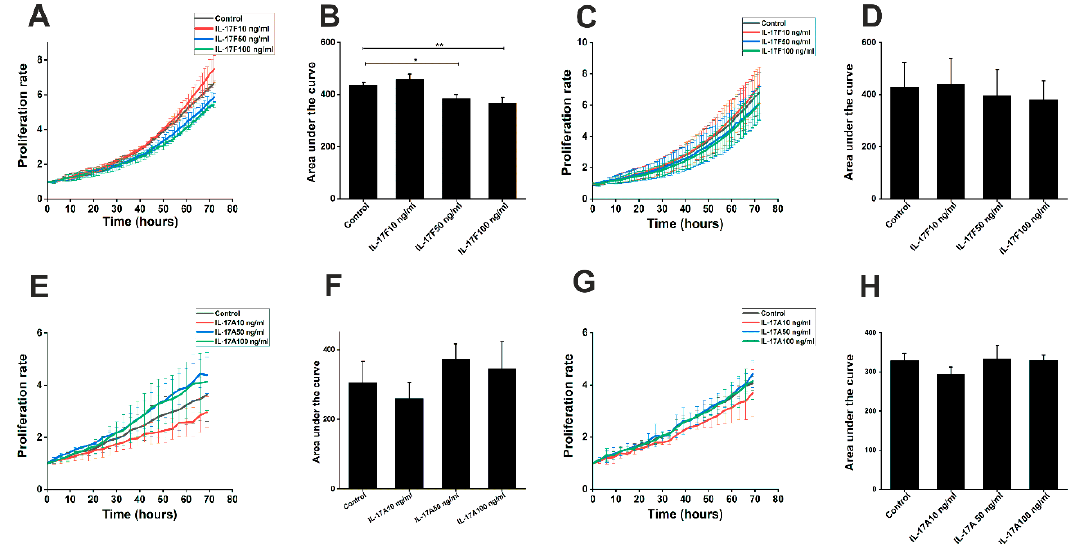
Figure 2. Effects of IL-17F and IL-17A on cancer cell proliferation in the label-free proliferation assay. ( A , B ) IL-17F suppresses HSC-3 cell proliferation at concentrations of 50 ( p = 0.04) and 100 ng/mL ( p = 0.008) compared with non-stimulated control samples. ( C , D ) Treatment of SCC-25 cells with IL-17F shows a similar but non-significant difference. ( E , F ) IL-17A produced an opposite effect to IL-17F and showed a slight induction of HSC-3 cell lines. ( G , H ) Similarly, IL-17A slightly induced SCC-25 proliferation, although no statistical significance was reached. Data are presented as means ± standard deviations. * p ≤ 0.05, ** p ≤ 0.01.